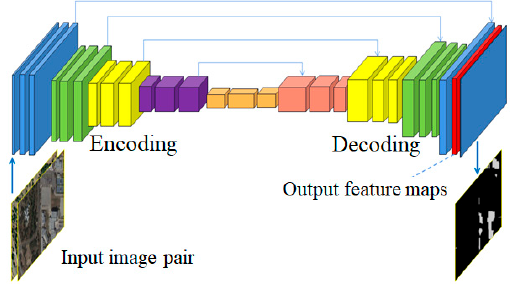
Figure 3. Illustration of the feature extracting network.